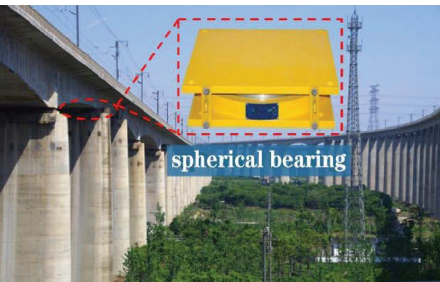
Figure 1: Spherical bearing used in a